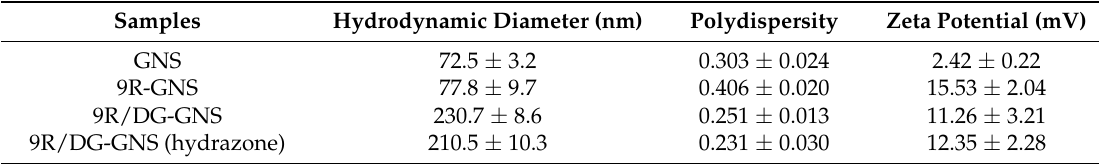
Table 1. Characterization of the hydrodyamic diameters and zeta potentials of nanoparticles.